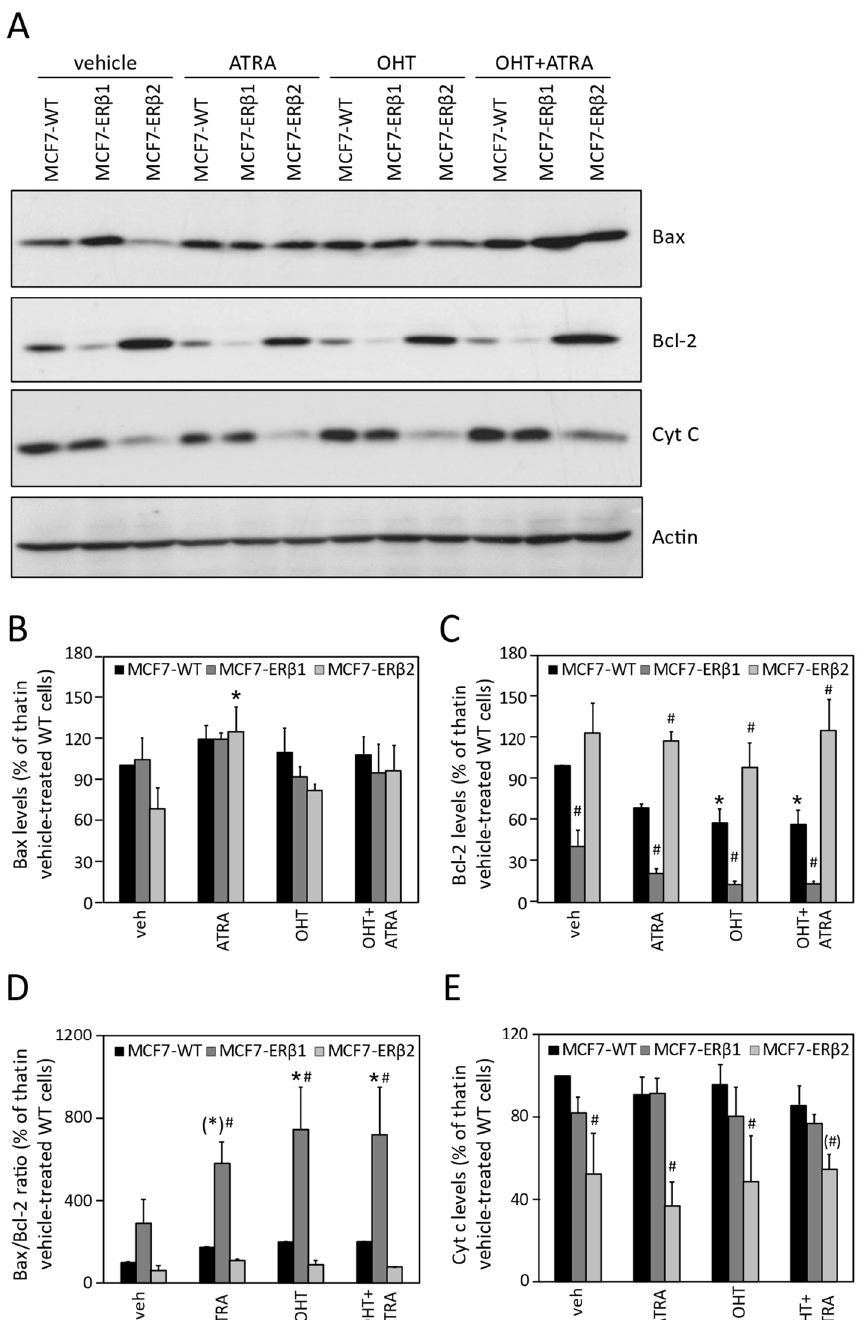
Figure 5. Modulation of Bax, Bcl-2 and cytochrome c expression by OHT, ATRA and their combination. ( A ) Western blot analysis of whole cell extracts from 2 × 10 5 MCF7-WT, MCF7-ER β 1 and MCF7-ER β 2 cells treated for 24 h with vehicle (0.1% DMSO), OHT (100 nM), ATRA (50 nM) or their combination, as indicated. Antibodies against Bax, Bcl-2, cytochrome c and actin (loading control) were used. ( B – E ) Densitometric analysis of Bax ( B ), Bcl-2 ( C ) and cytochrome c protein bands. Density of Bax, Bcl-2 and cytochrome c protein bands was normalized to density of the respective actin bands and expressed relative to that of vehicle-treated MCF7-WT cells. The Bax/Bcl-2 ratio was calculated from the respective Bax and Bcl-2 band densities. * p < 0.05 and (*) p = 0.07 vs. vehicle of the respective cell line, # p < 0.05 and (#) p = 0.08 vs. similarly treated MCF7-WT cells. OHT, 4-hydroxytamoxifen; ATRA, all-trans retinoic